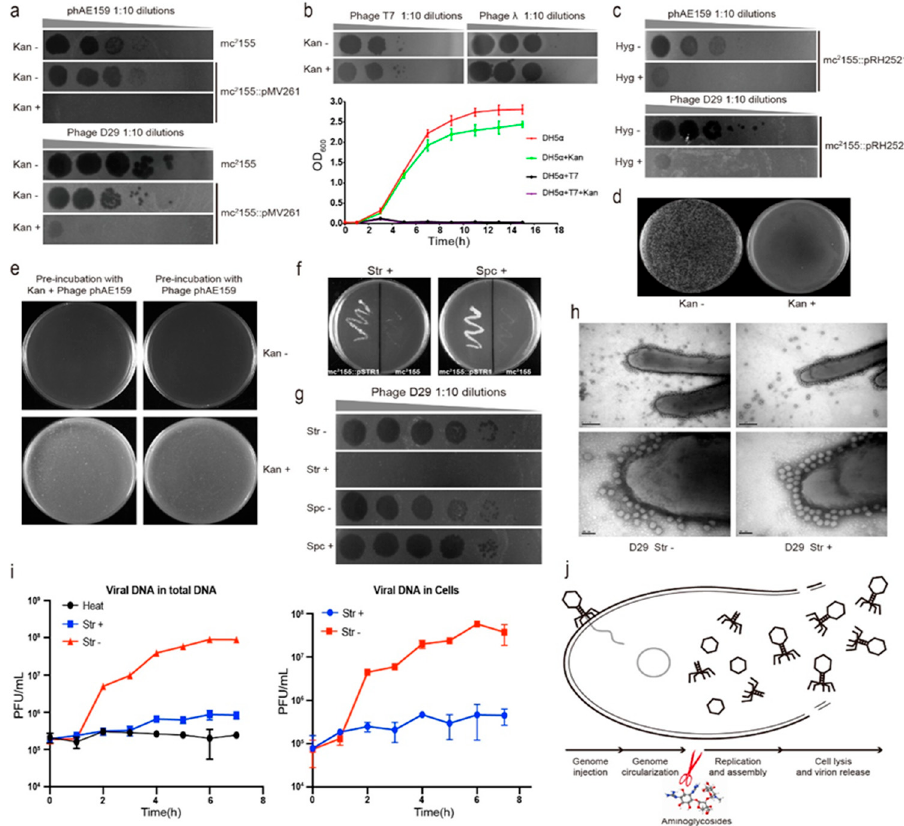
Figure 1. Aminoglycoside antibiotics inhibit the DNA replication of mycobacteriophages. ( a ) The replication of the two mycobacteriophages phAE159 and D29 were inhibited by kanamycin on lawns of M. smegmatis mc 2 155. ( b ) Kanamycin did not affect the infection of Escherichia coli phages T7 and λ . ( c ) Hygromycin was able to inhibit the infection of mycobacteriophages phAE159 and D29. ( d ) Kanamycin inhibited the formation of plaques by electrotransformation of phAE159 vector. ( e ) Pre-incubation with kanamycin did not affect the infection of mycobacteriophage phAE159. ( f ) M. smegmatis mc 2 155 harboring the recombinant plasmid tolerated streptomycin and spectinomycin well. ( g ) The propagation of mycobacteriophage D29 was significantly inhibited in the presence of streptomycin but had no effect in the presence of spectinomycin. ( h ) TEM analysis of the adsorption capacity of mycobacteriophage in the presence of streptomycin. ( i ) Quantitative PCR analysis of phage DNA proliferation during the infection process. ( j ) Aminoglycosides were speculated to be able to block the DNA replication during the life cycle of phage (adapted from Figure 3a in [21]).